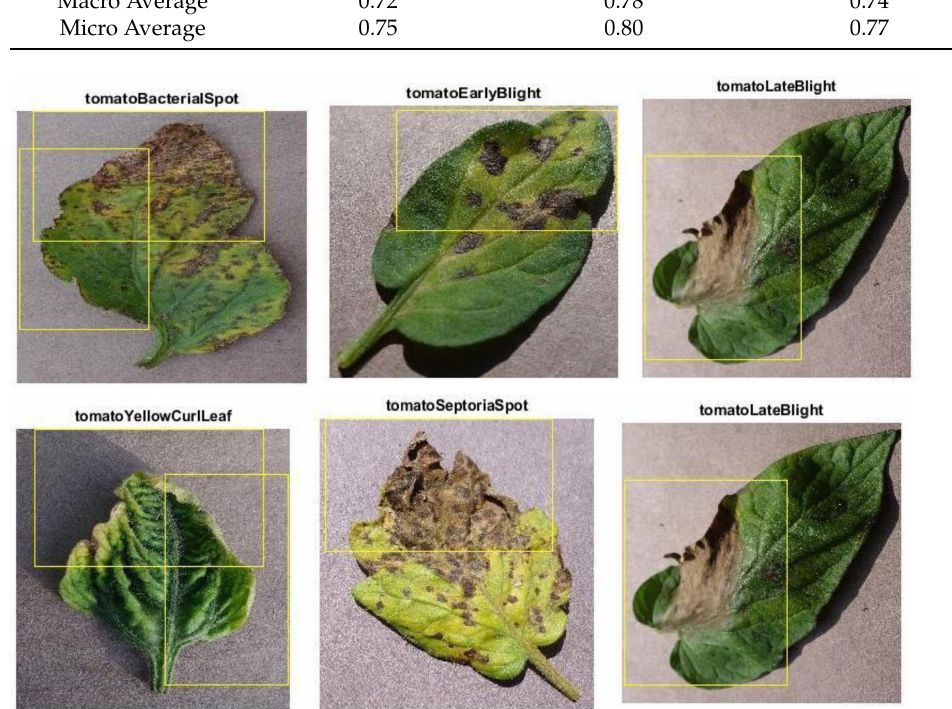
Figure 15. The visual result of the proposed model on testing